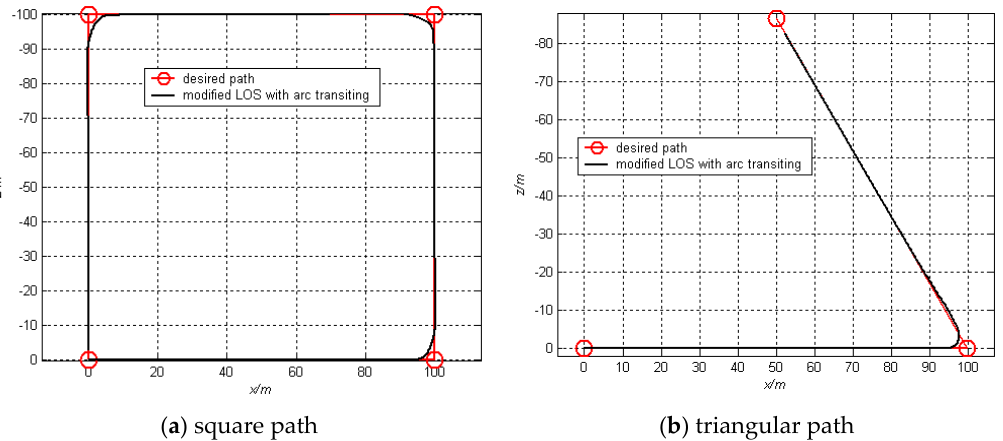
Figure 25. Simulation results with the modified LOS and arc transiting at the corners.